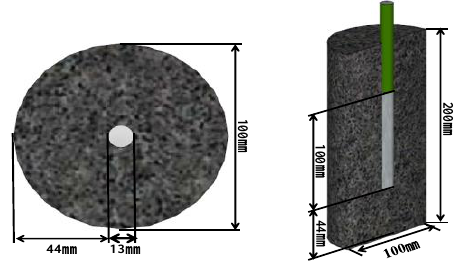
Figure 2. Schematic diagram of specimen for electrochemical measurement.